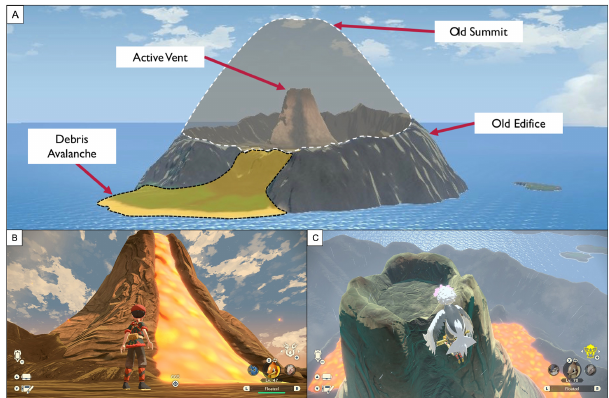
Figure 5. Images of the volcano, Firespit Island, located in the Cobalt Coastlands in Pokémon Legends: Arceus (Fig. 1a3) (a) An- notated schematic of Firespit Island showing a hypothetical look of the volcano pre-sector collapse and highlighting the resulting de- bris avalanche. (b) Close-up of the steep, central active vent with lava flowing out. (c) Volcanic plug that forms after the lava erup- tion ceases. ©The Pokémon Company International (2022a). There is no direct comparison for this volcano found on Hokkaido, Japan (Fig.